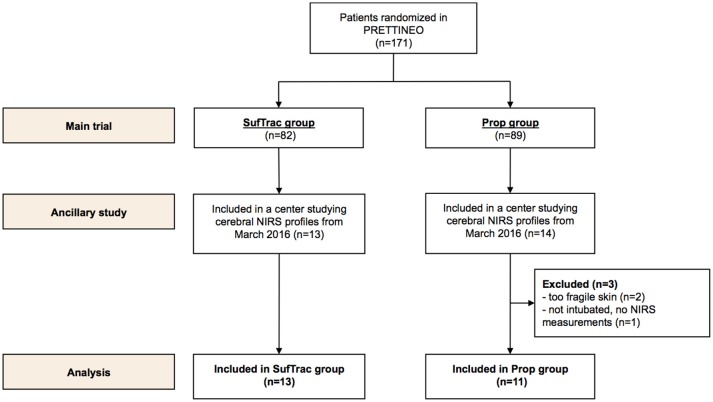
Population flow chart.